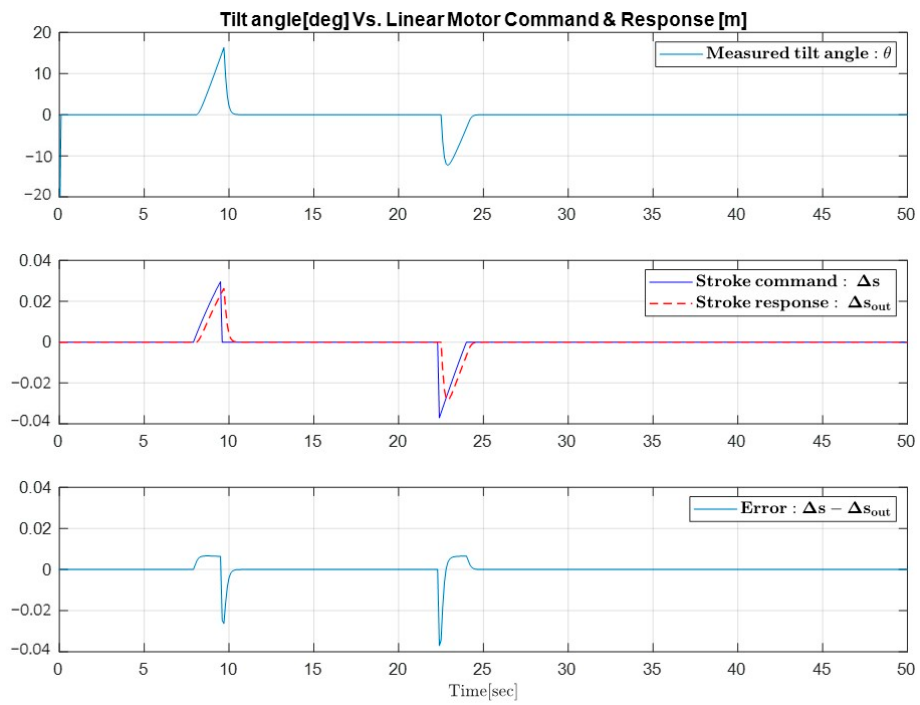
Figure 17. Experiential results of Case I: storage box tilt angle and linear motor stroke command vs. resulting output.